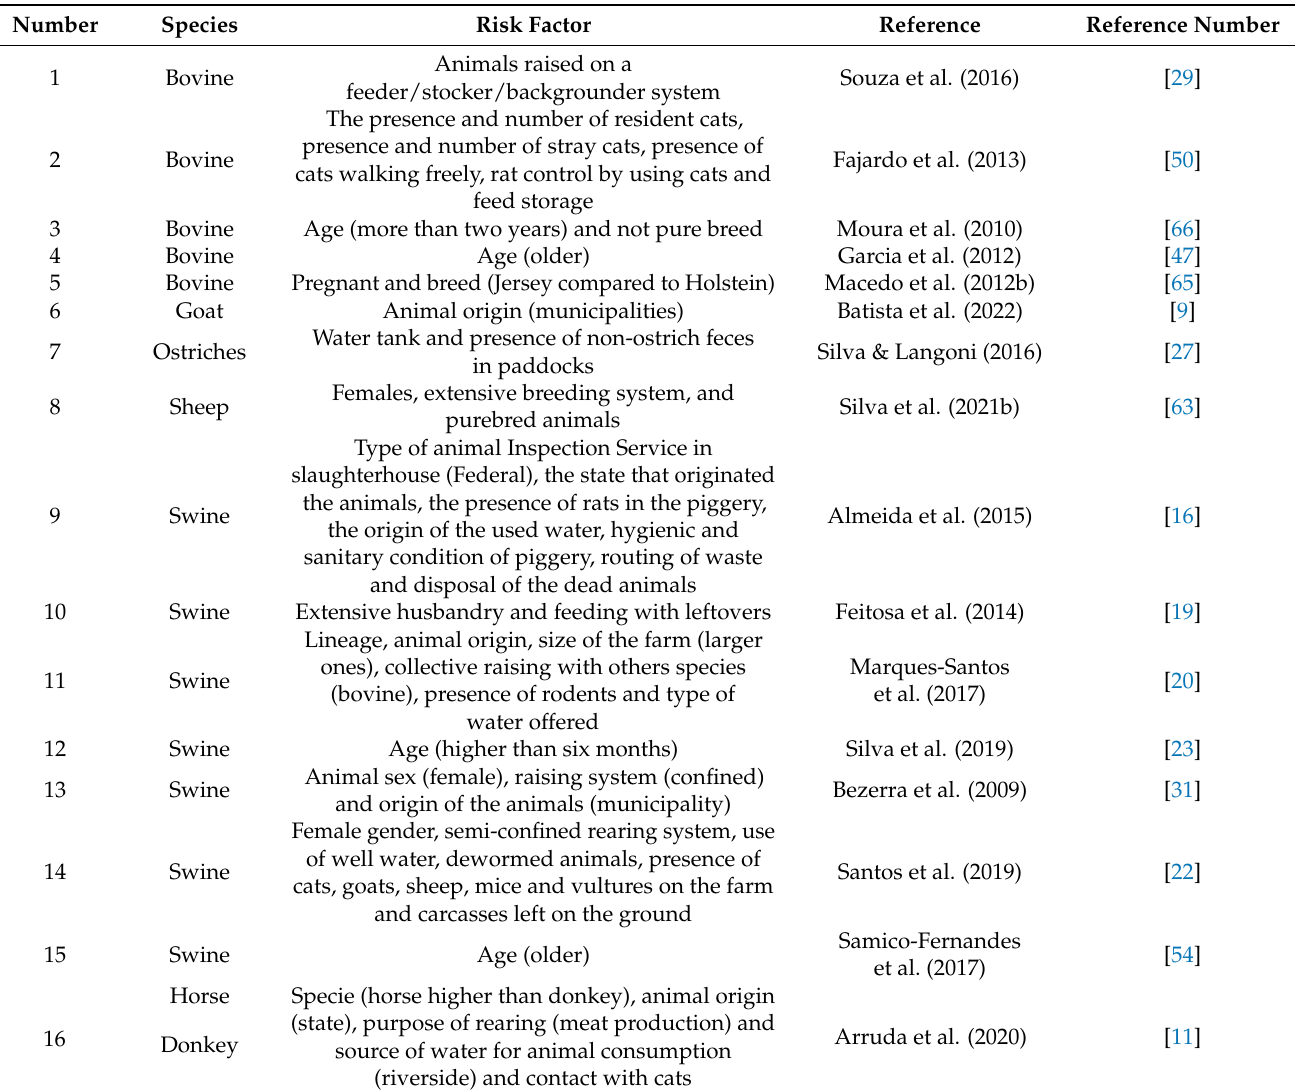
Table 1. Risk factors for toxoplasmosis infection in animals slaughtered for human consumption in